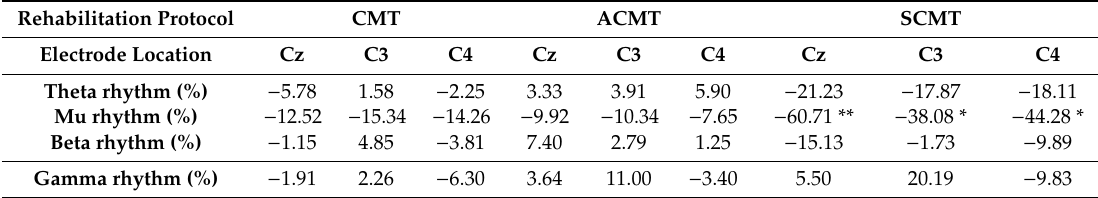
Table 2. Absolute power spectral density (PSD) changes of each frequency band according to the rehabilitation